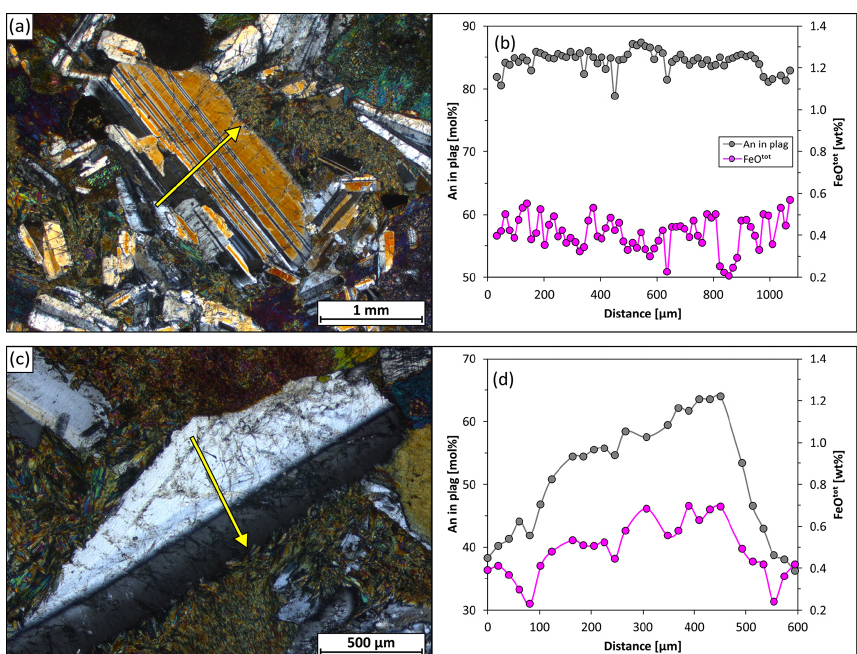
Figure 9. Contrasting compositional features for plagioclases from typical poikilitic (sample GT3A-97Z-2, 35–40cm; a, b ) and granular domains (sample GT3A-109Z-3, 39–47cm; c, d ). (a, c) Microphotograph with plane-polarized light; (b, d) EPMA profile for An and FeO content. Plagioclase from poikilitic domains (a, b) shows only minor compositional variation with generally higher An contents (up to An 86). In contrast, plagioclases from the granular domain show in general a strong zoning with significantly lower An contents (c, d) . The yellow arrows mark the start and end of the EPMA